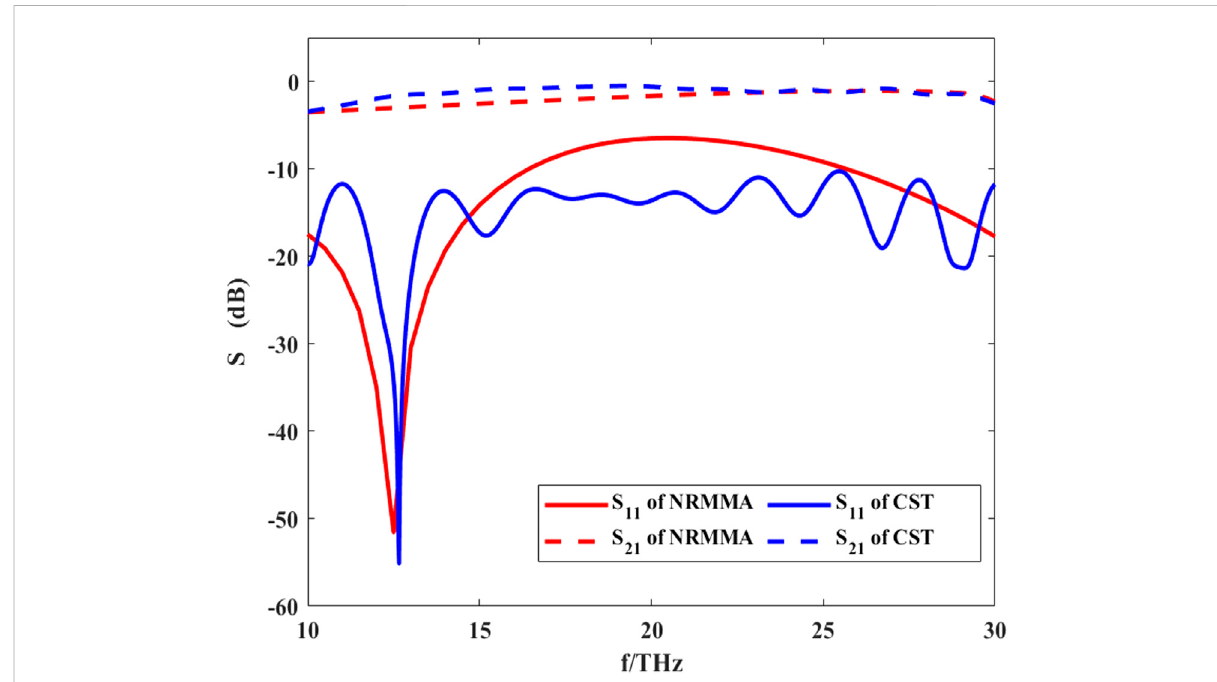
FIGURE 9 S-parameters of THz-FIR wave propagation at the nodes of Ranvier calculated by RNMMA and